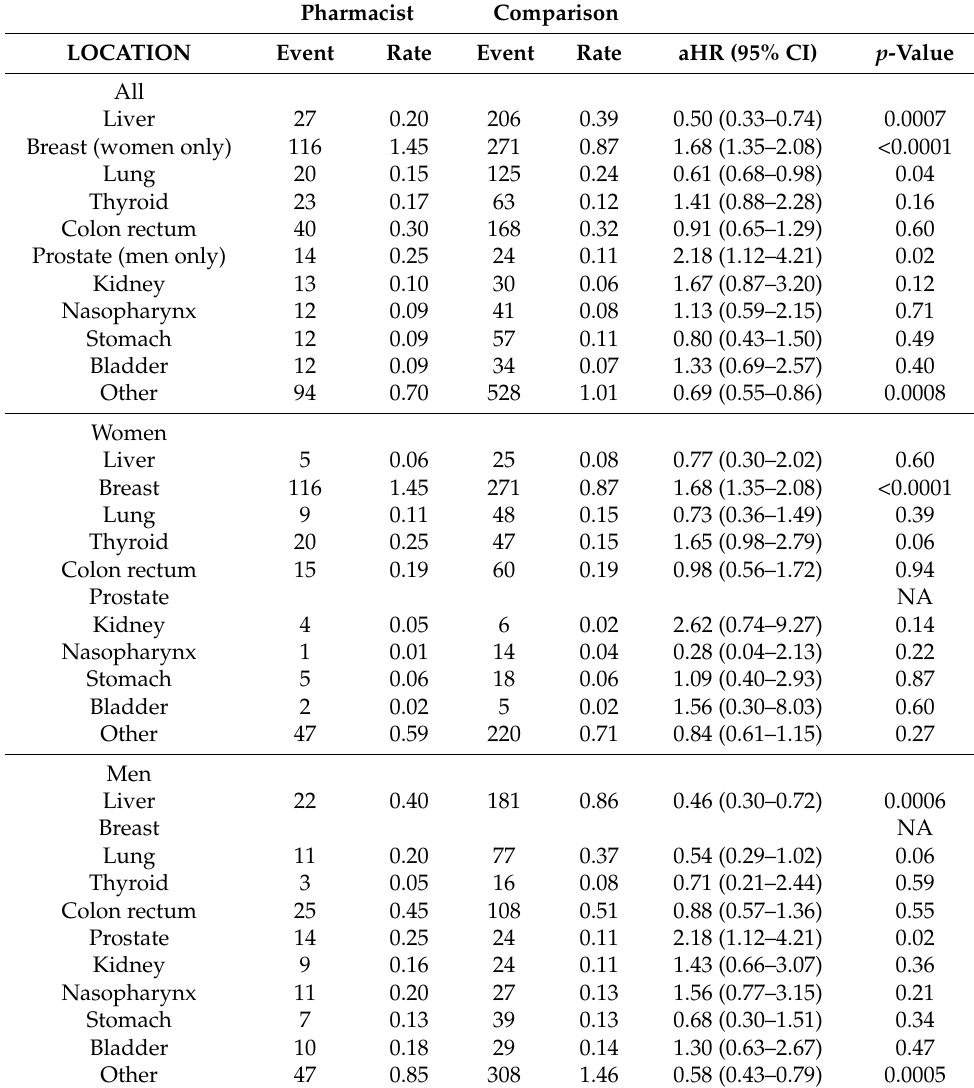
Table 3. Cancer incidence and risk in different locations by